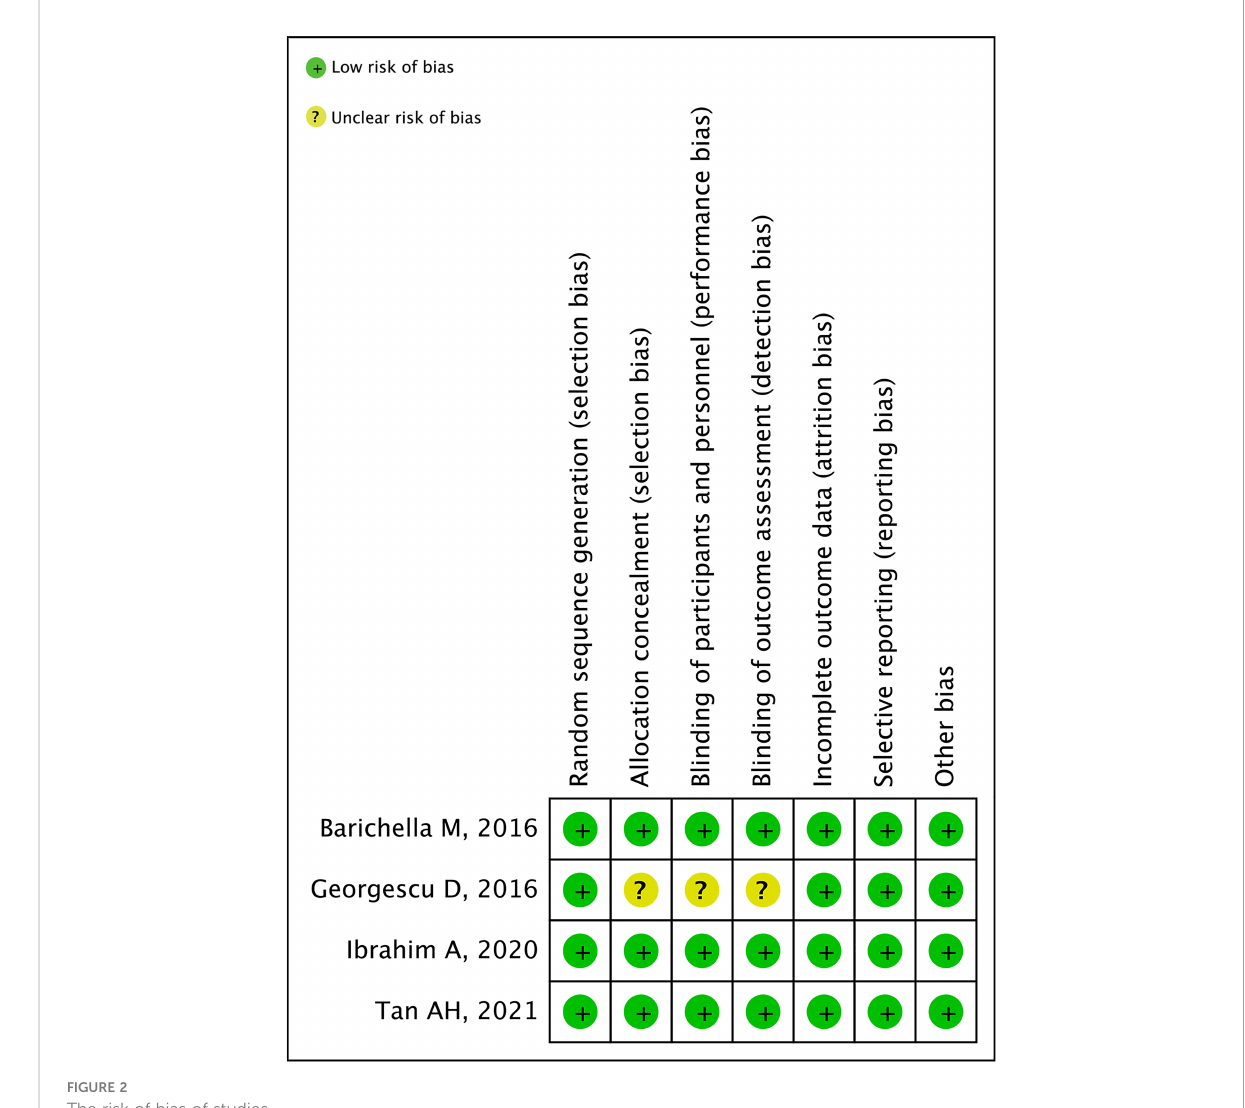
FIGURE 2 The risk of bias of